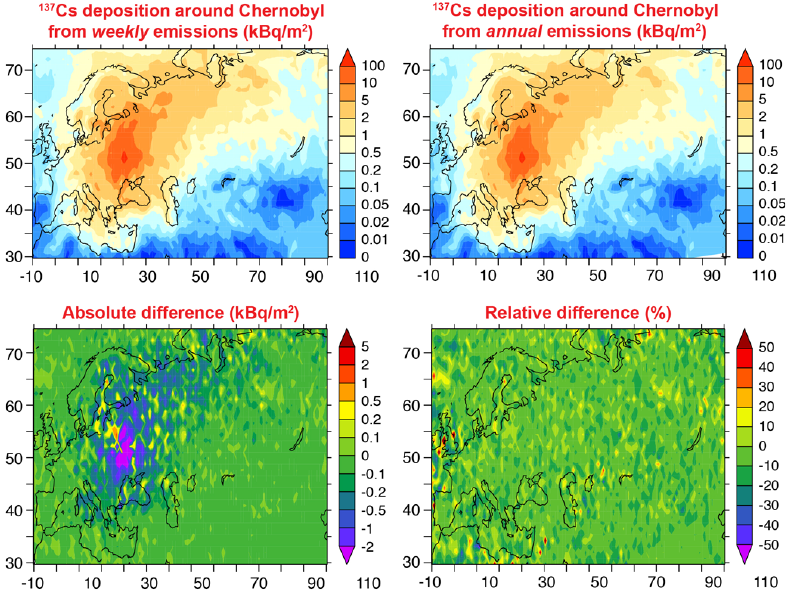
Fig. 8. Yearly-integrated fallout of 137 Cs (year 2005), comparing annually continuous to weekly emissions (both the same total source strength of Chernobyl), released from the location of Chernobyl.